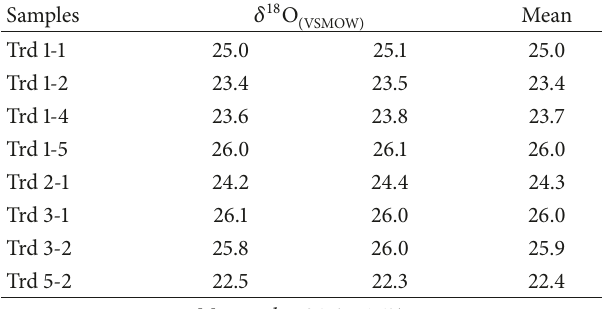
Table 5: 𝛿 18 O ( of chert samples from the quarries in Triadi VSMOW ) of Thessaloniki (Central Macedonia,